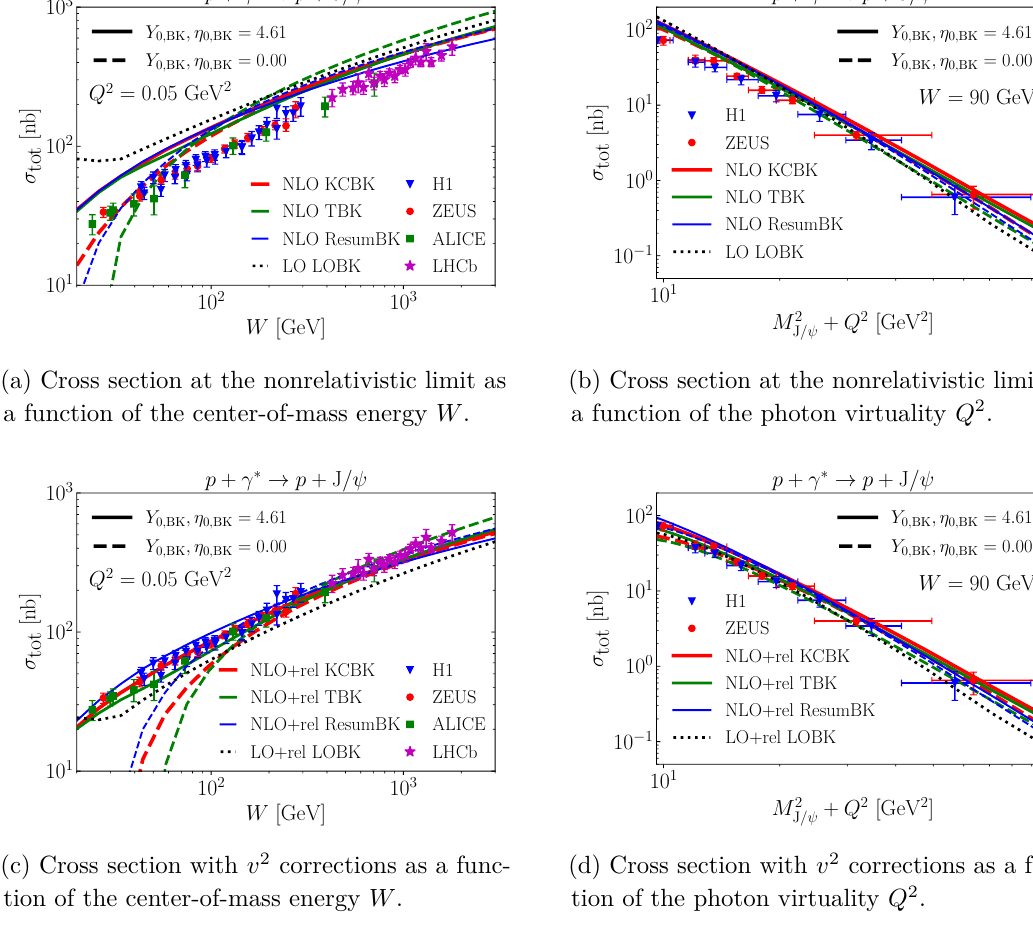
Figure 4. Total exclusive J /ψ production at next-to-leading order, with HERA data from [7–9, 14], ALICE data from [19, 20], and LHCb data from [22,